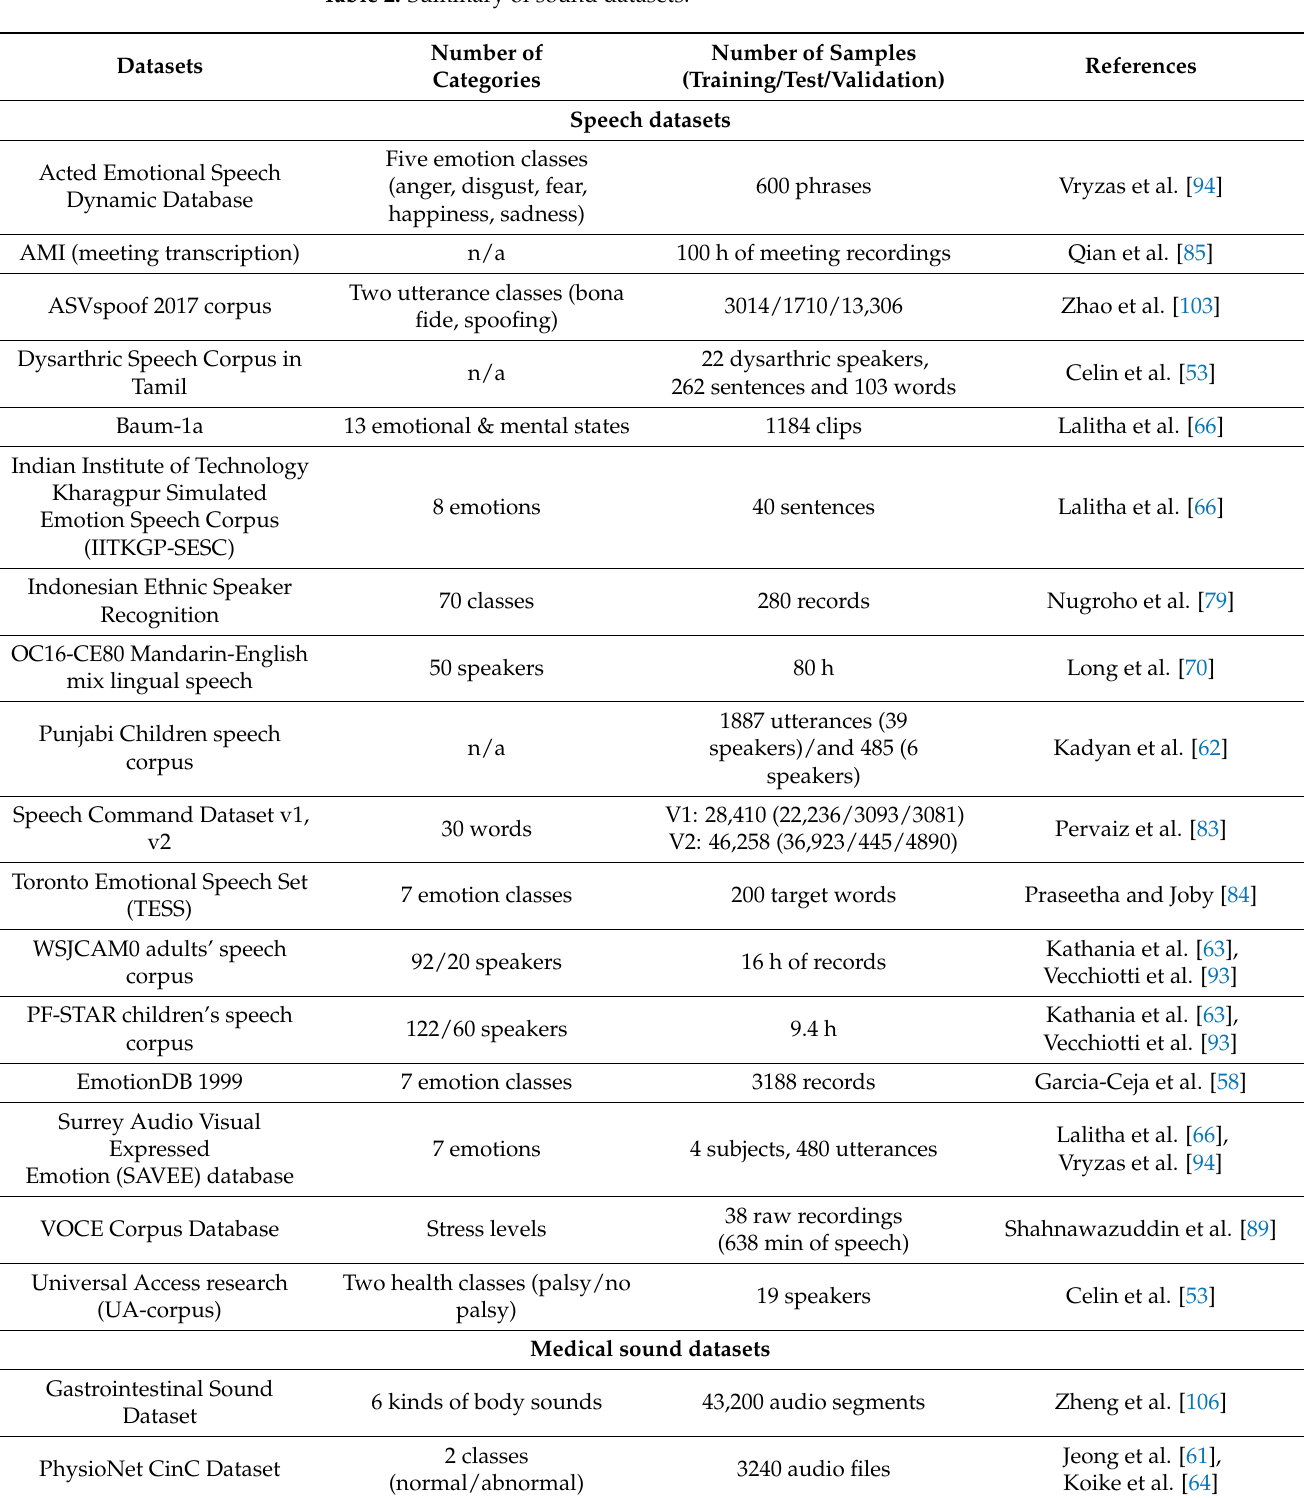
Table 2. Summary of sound